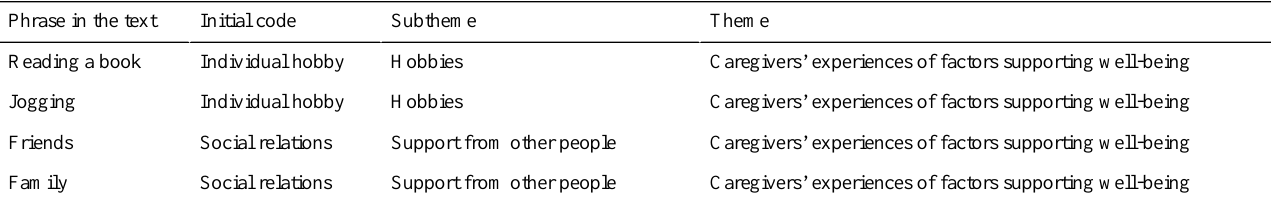
Table 2. Example from a coding tree of caregivers’well-being. ThemeSubthemeInitial codePhrase in the text